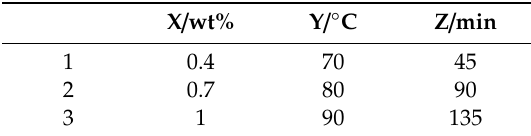
Table 2. Factor level of the orthogonal